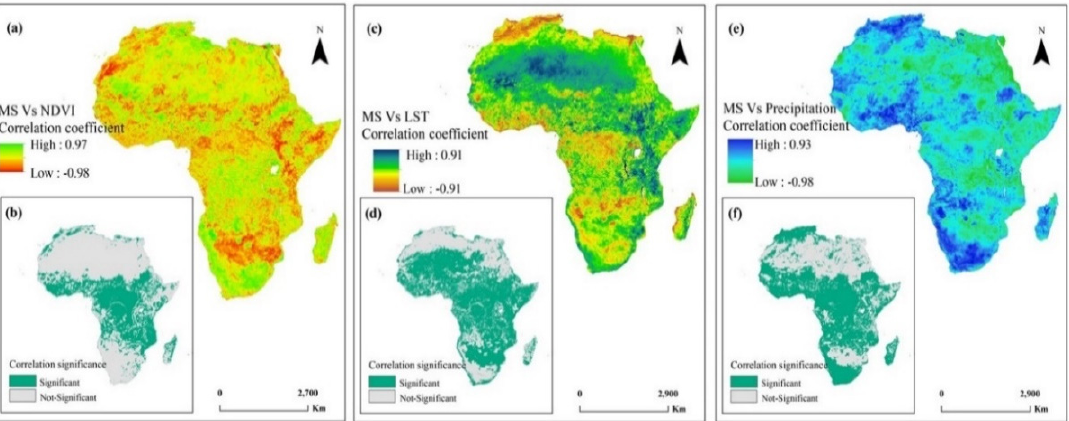
Figure 11. Relationship between annual soil moisture (SM) change versus ( a ) Normalized Difference Vegetation Index (NDVI), ( c ) Land Surface Temperature (LST), and ( e ) precipitation during the 2003–2017 period in Africa; respective correlation significances ( b , d , f